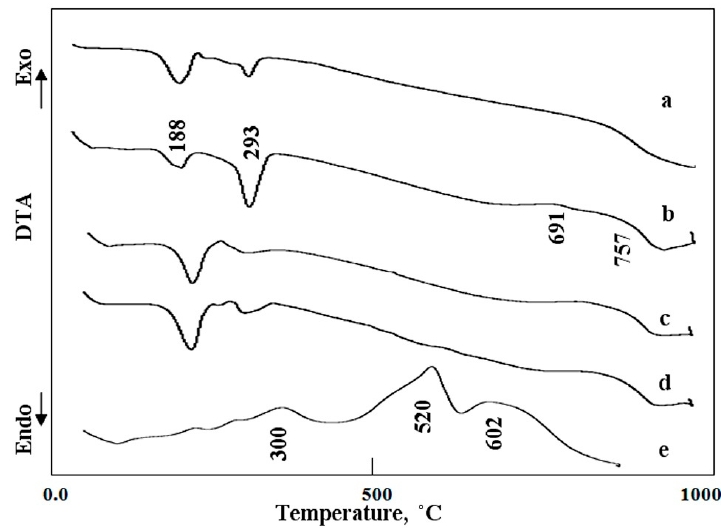
Figure 5. Di ff erential Thermal Analysis (DTA) curves of: ( a ) Zn-Al LDH, ( b ) Zn-Al-GO1, ( c ) Zn-Al-GO2, ( d ) Zn-Al-GO3 and ( e ) the prepared graphene.